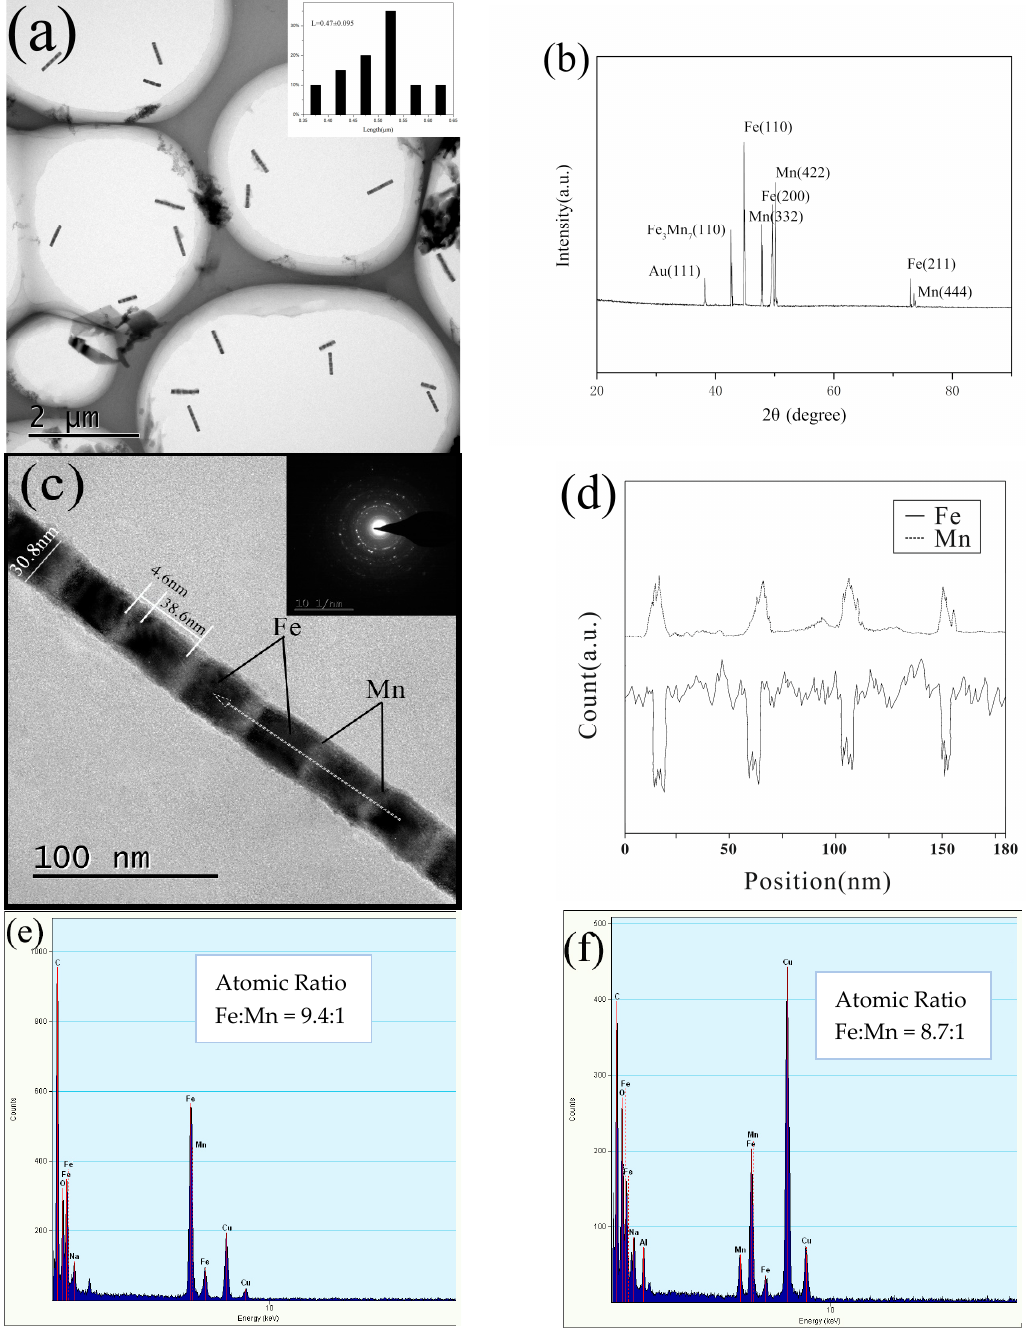
Figure 3. Characterization of multilayer 4# Fe/Mn NWs: ( a ) TEM image of a large number of NWs; the inset shows the length distribution of NWs; ( b ) XRD of NWs; ( c ) TEM image of a single NW; ( d ) EDX linear scan of a single NW; ( e ) EDS analysis of a single NW; ( f ) EDS spectra of a large number of NWs.